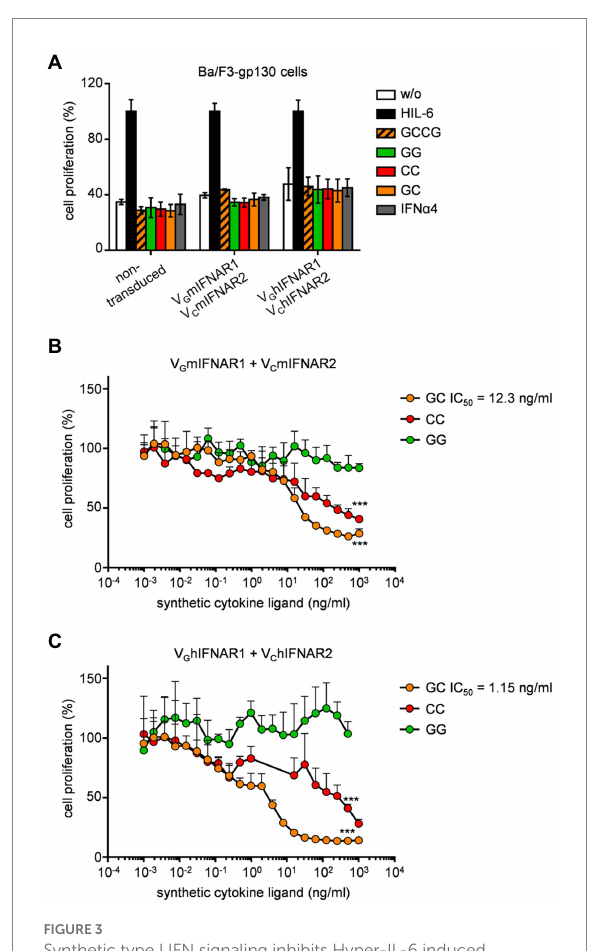
with 10 ng/ml Hyper-IL-6 in the presence of increasing concentrations of GG, CC, and GC (0.001–1,000 ng/ml). One representative experiment out of three is shown. (C) Proliferation of Ba/F3-gp130-V G hIFNAR1-V C hIFNAR2 cells with 10 ng/ml Hyper-IL-6 in the presence of increasing concentrations of GG, CC, GC (0.001–1,000 ng/ml). One representative experiment out of three is shown. *** p